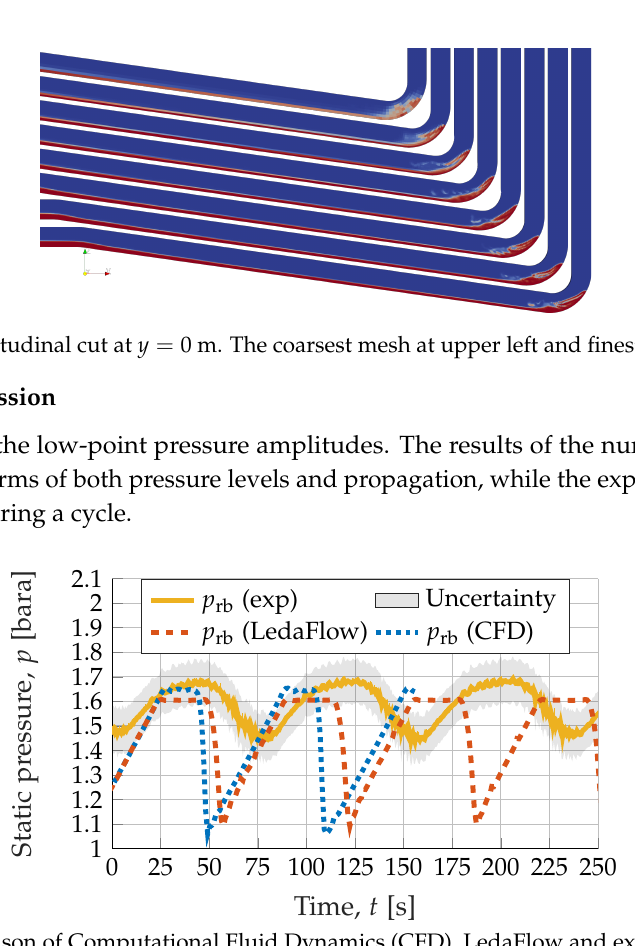
Figure 8. Comparison of Computational Fluid Dynamics (CFD), LedaFlow and experimental results for the low-point pressures.